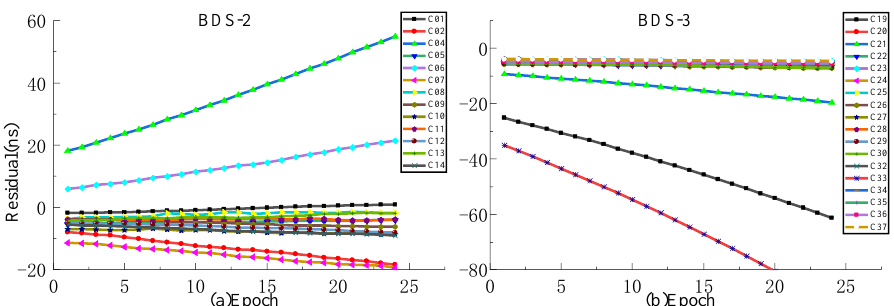
Figure 11. The residual plot of GM model using the initial hour update ultra-fast clock product of the next day. ( a ) The residual value of BDS-2 predicted after 6 h. ( b ) The residual value of BDS-3 predicted after 6 h.